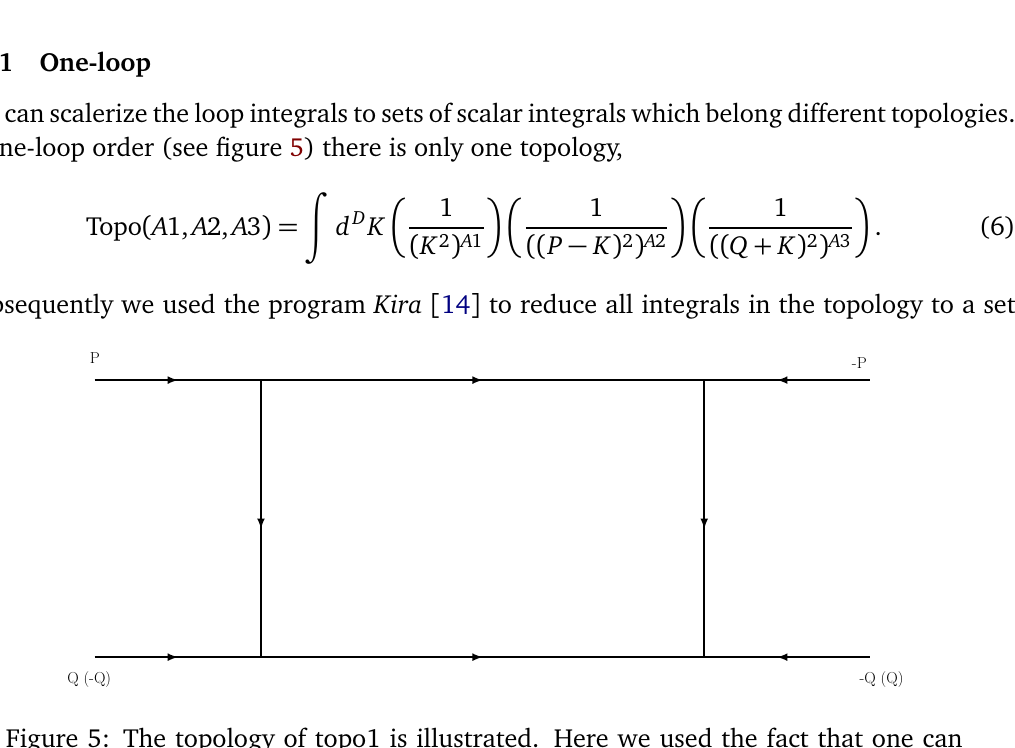
Figure 5: The topology of topo1 is illustrated. Here we used the fact that one can exploit the symmetry Q ↔ − Q to reduce the diagrams to a single